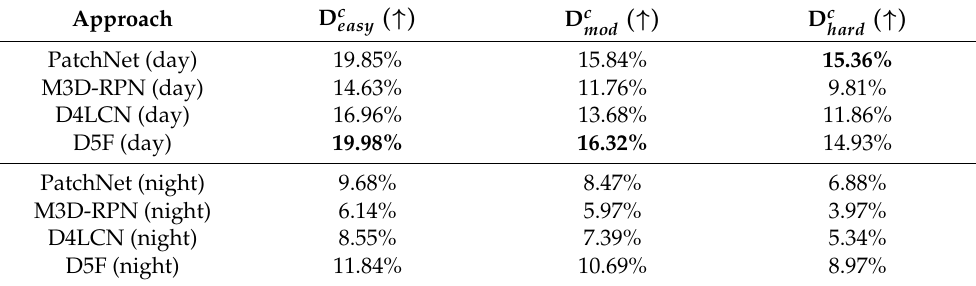
Table 6. Average precision in terms of center distance for three difficulty levels ( D c easy , D c D c ). The best values are displayed in bold. hard